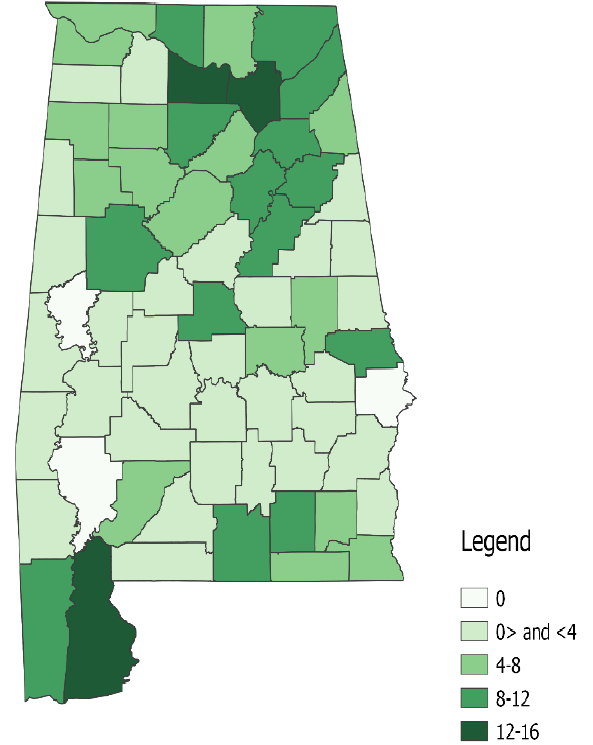
Figure 4. The spatial distribution of high schools with agriculture-related courses across Alabama’s counties.